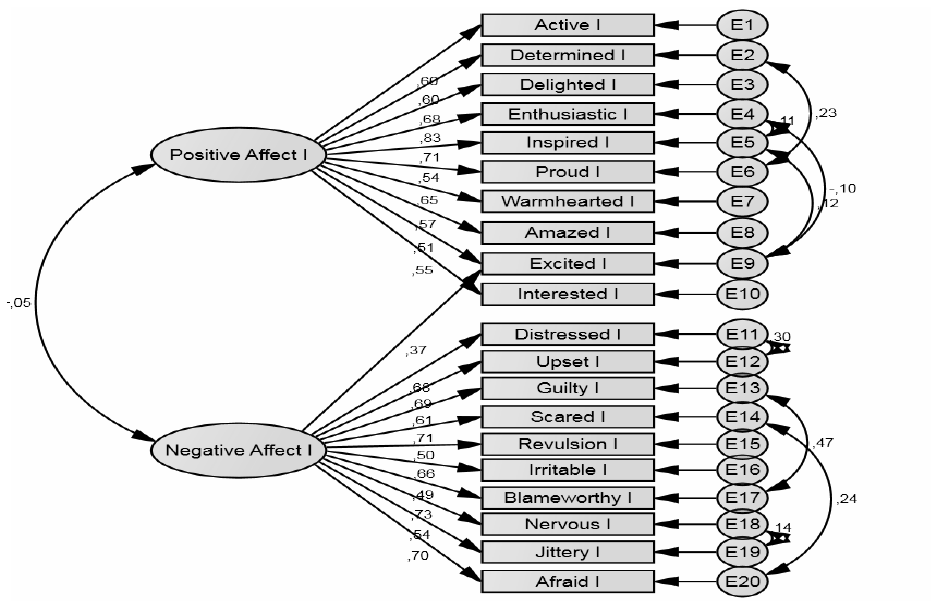
Figure 1 . Factor Structure of the PANAS. Alternative Model 7